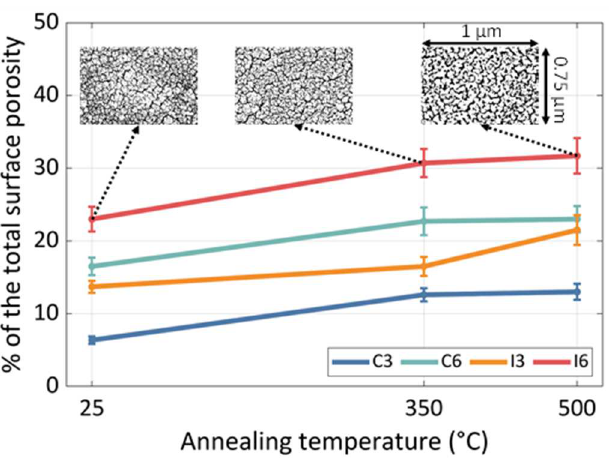
Figure 4. Percent of the total surface porosity vs. annealing temperature. The inserts show binary SEM images for I6 films (analyzed surface around 0.75 µm²).